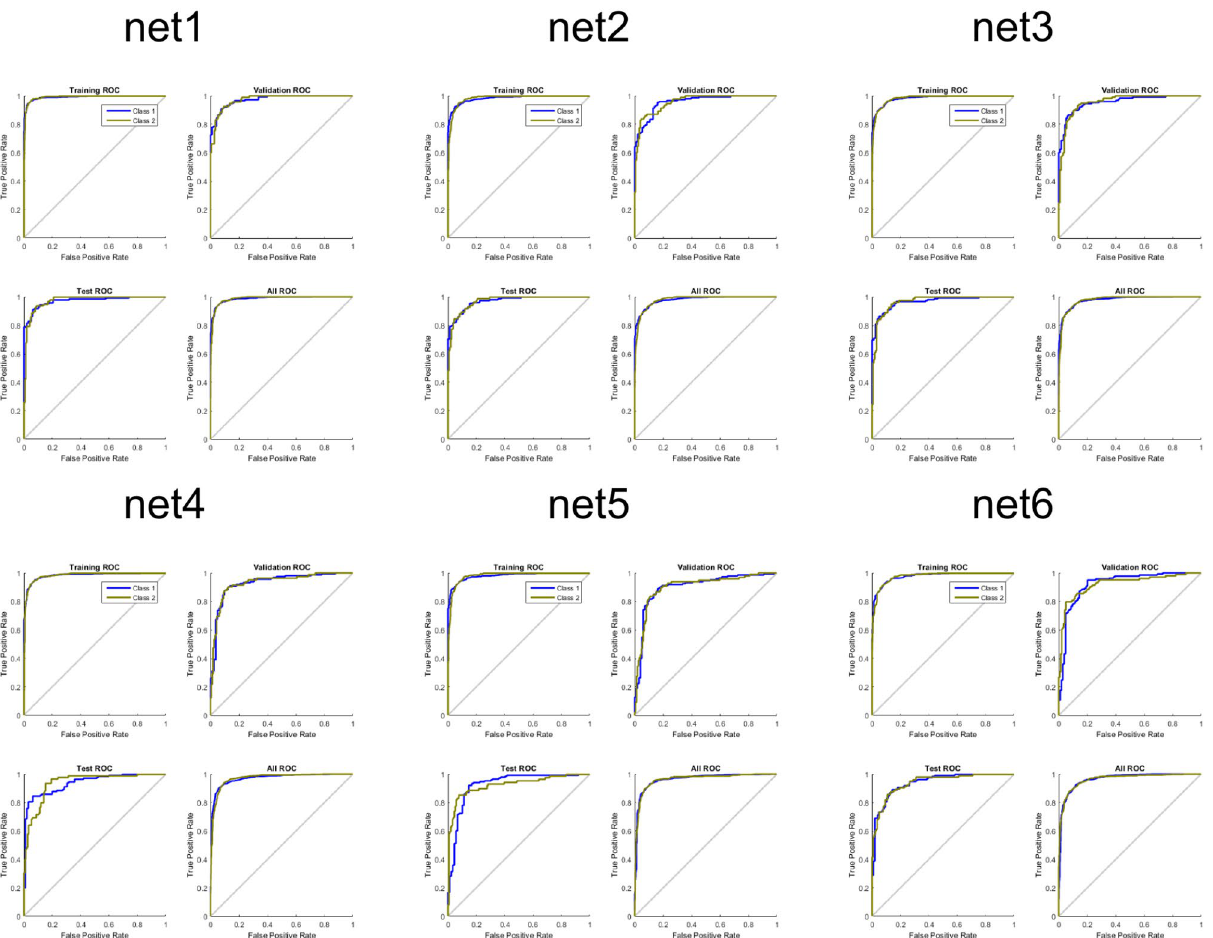
Figure 8. Receiver operating characteristic for the different neural networks. Class 1 means artifacts, Class 2 means